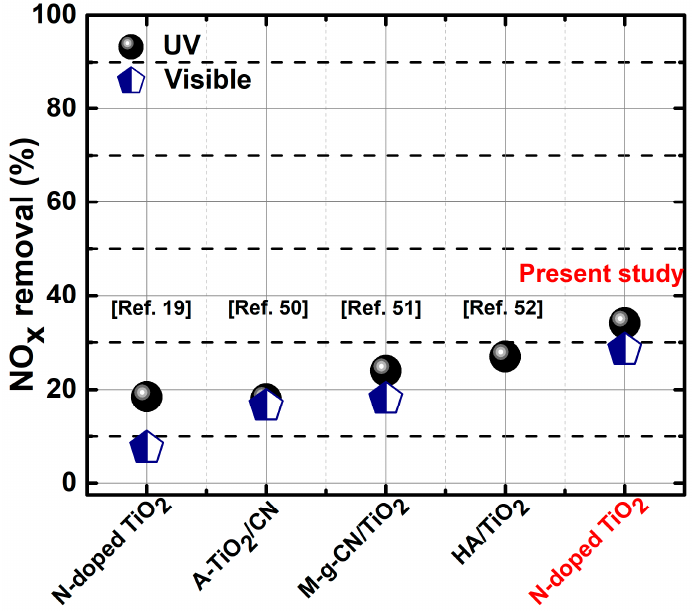
Figure 8. Comparison of NOx removal performance in the UV and visible regions with some advanced studies.